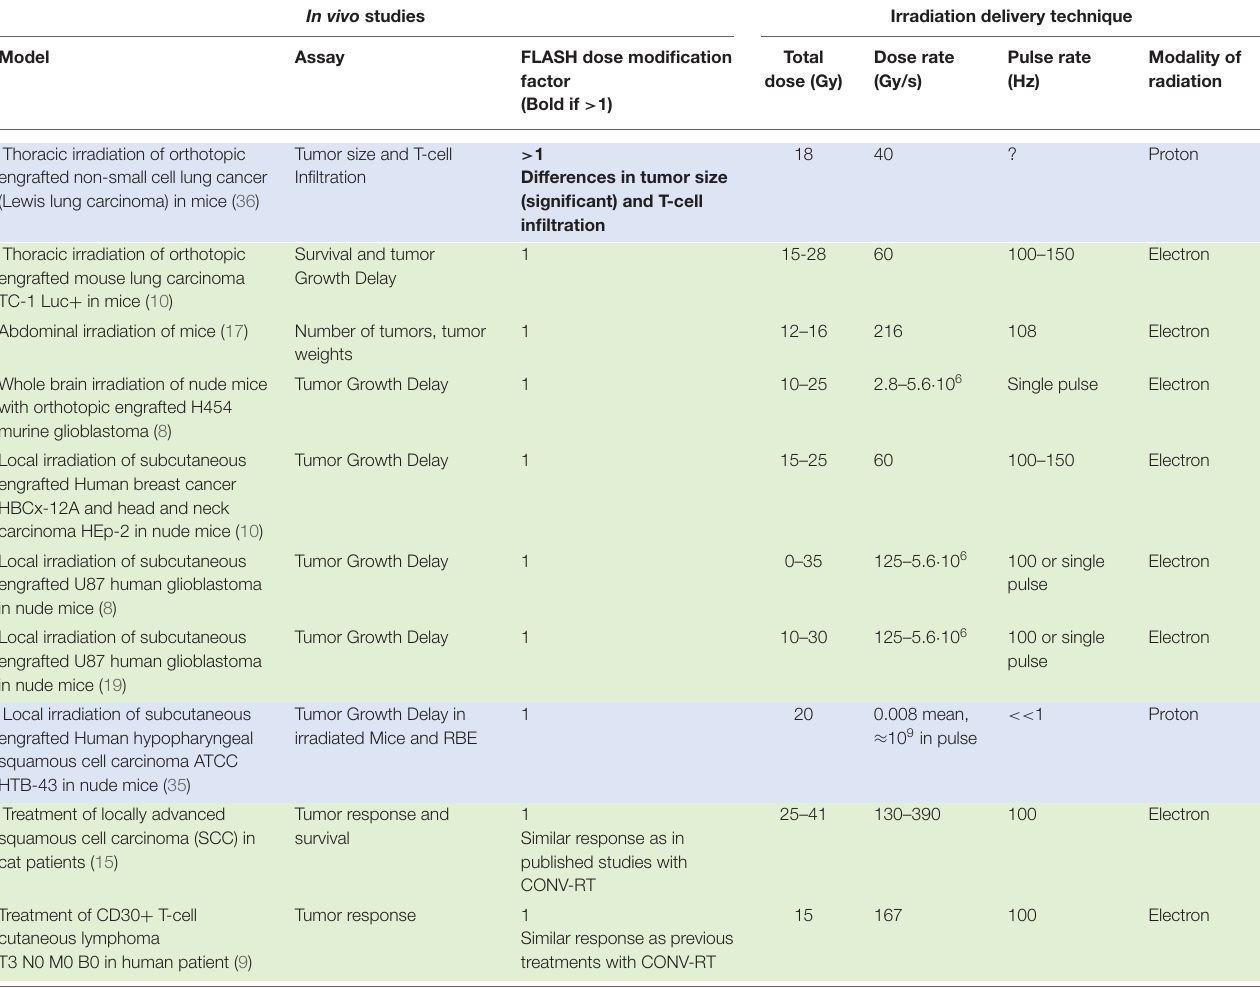
TABLE 2 | Summary of irradiation parameters and outcomes for in vivo studies investigating the FLASH effect in tumor tissues (organized in order of model species and targeted tissue, as well as color coded by radiation modality). In vivo